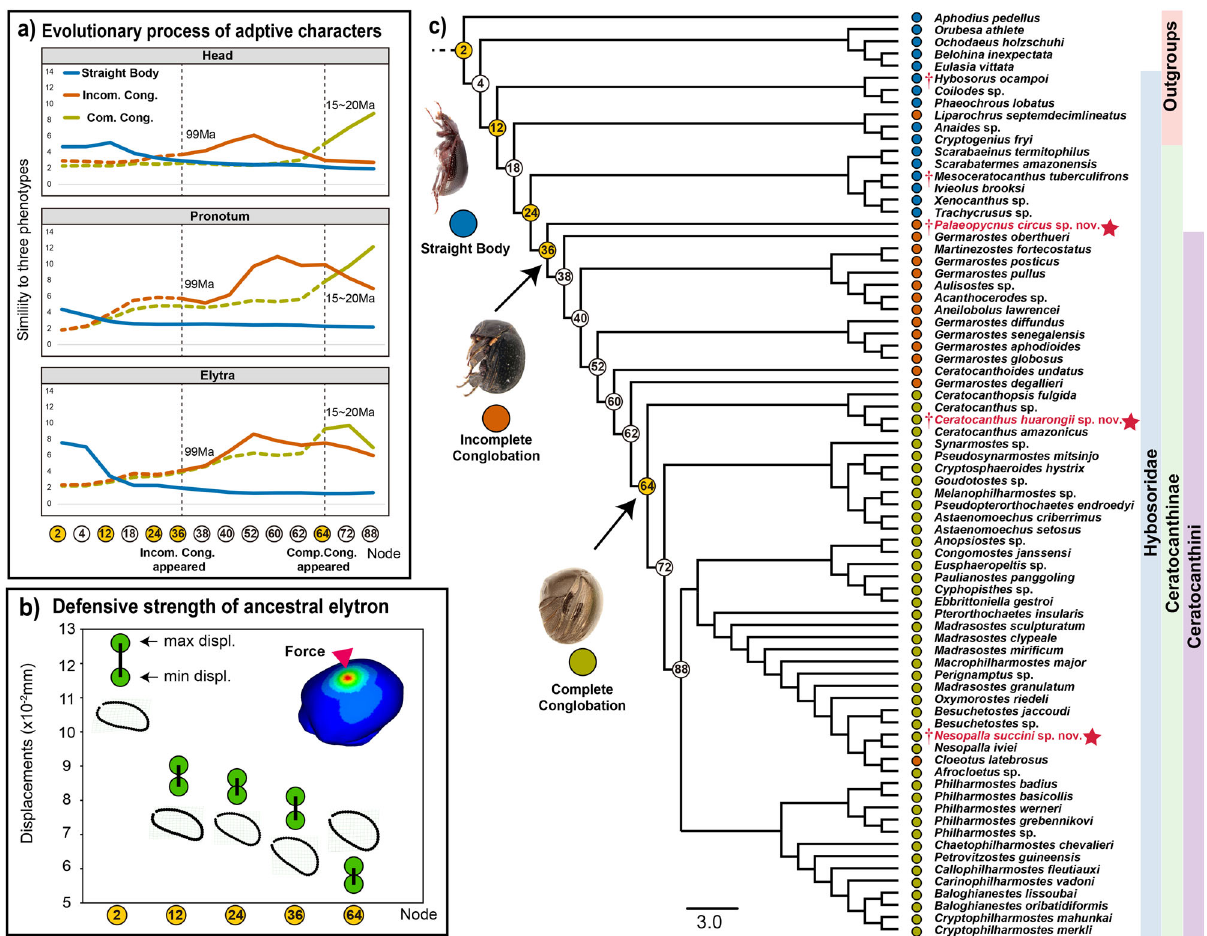
Fig. 6 Ancestral state reconstruction of key nodes illustrates the evolutionary process of characters associated with conglobation adaptation. a Trend line of similarities of the reconstructed shapes at key nodes to the three archetypes (straight body, incomplete conglobation and complete conglobation). The similarities are represented by reciprocals of normalized distances (the sum of distances to the three archetypes normalized as 1). b The result of fi nite element analysis (FEA) of the reconstructed elytron at selected representative nodes (nodes 2, 12, 24, 36 and 64); higher displacement means lower defensive strength. c The topology of the phylogenetic tree derived from the fi rst of the fi ve most parsimonious trees obtained in the phylogenetic analysis. Terminals are coloured according to the three conglobation archetypes (blue circles represent a straight body, orange circles represent incomplete conglobation, and yellow – brown circles represent complete conglobation). Red stars for the terminal taxa indicate the extinct taxa newly described in this article. Numbers within circles represent the ancestral nodes; orange circles indicate the selected representative nodes (see